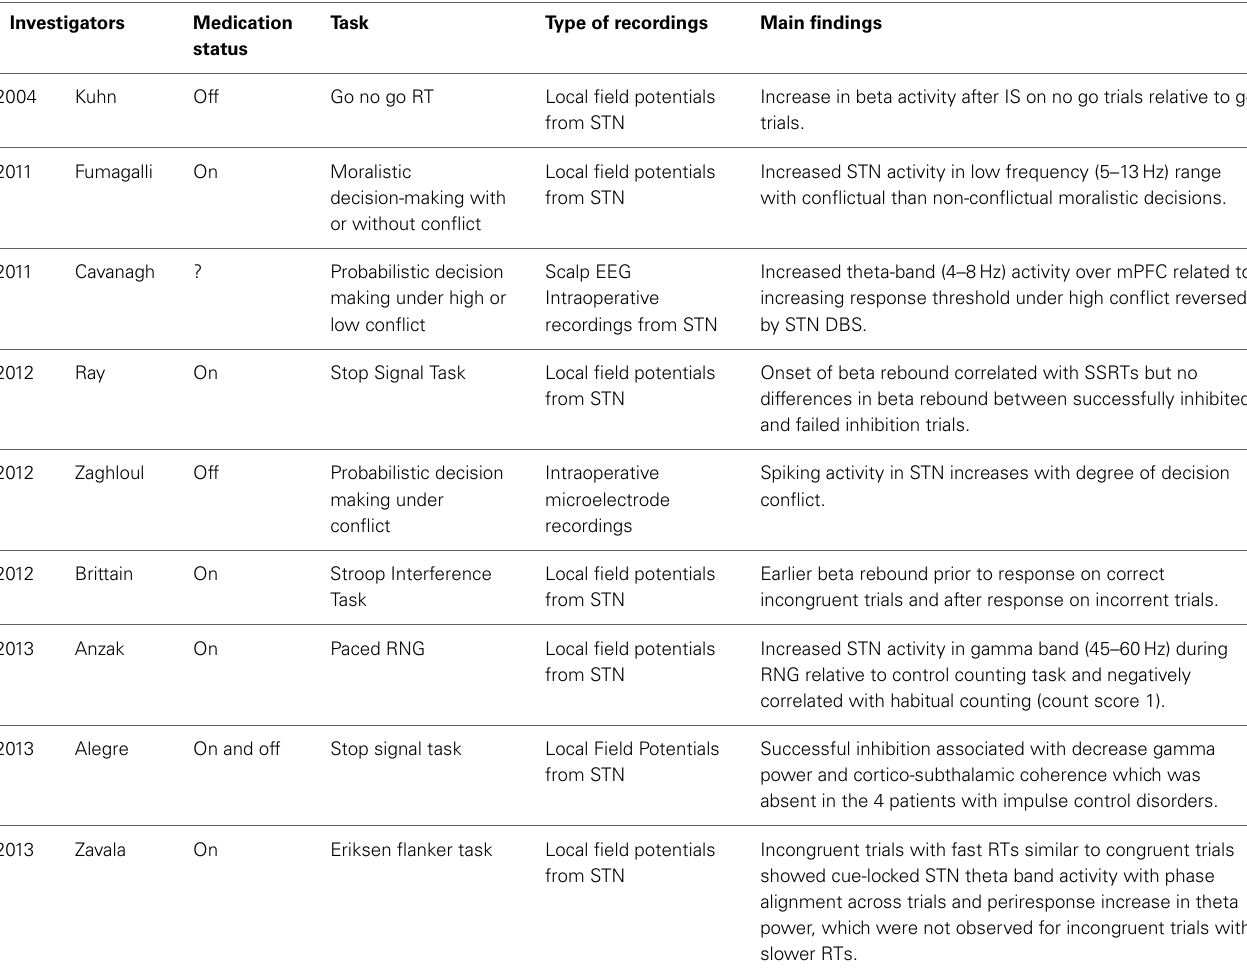
Table 2 | Studies recording local field potentials or intraoperative micro-electrode recording of neuronal activity from the subthalamic nucleus (STN) in patients with Parkinson’s